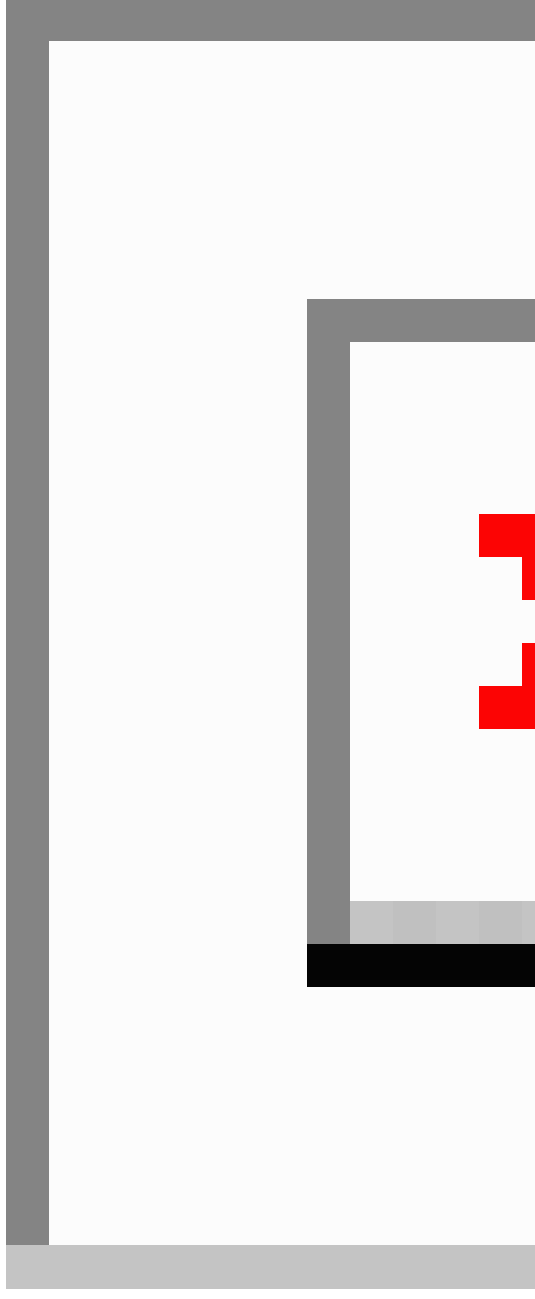
Figure 1. Flow of participants in the randomized controlled